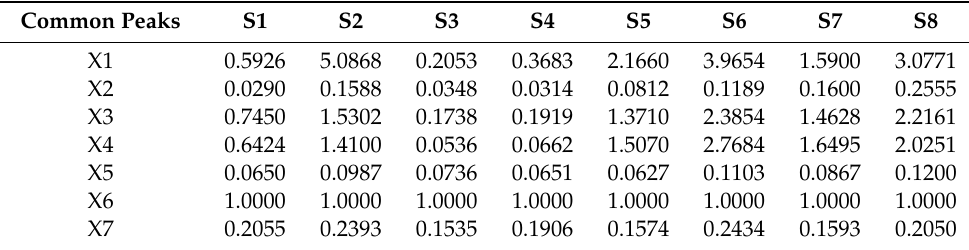
Figure 2. HPLC fingerprint ( A ) and total ion current (TIC) chromatogram ( B ) of Nü-Er-Cha. Table 2. The relative peak area of common peaks. Table 2. The relative peak area of common peaks.